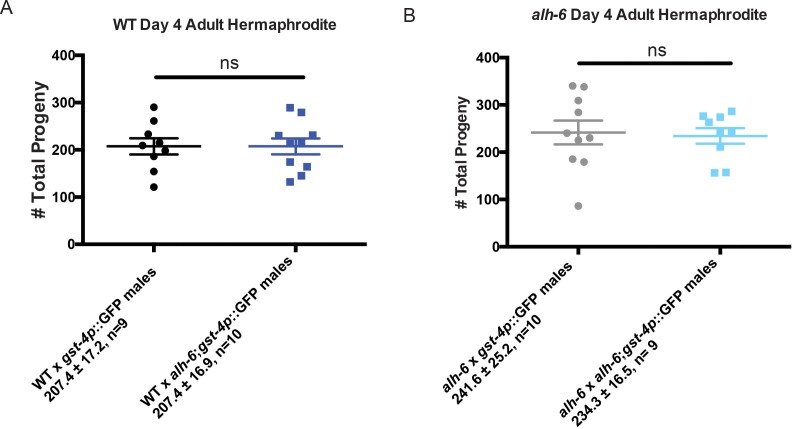
alh-6 fertility defects are sperm-specific.(A) Day four adult WT hermaphrodites mated to either gst-4p::gfp or alh-6;gst-4p::gfp males yield similar total brood size. (B) Day four adult alh-6 hermaphrodites mated to either gst-4p::gfp or alh-6;gst-4p::gfp males yield similar total brood size. Comparisons made with unpaired t-test. *, p<0.05; **, p<0.01; ***, p<0.001; ****, p<0.0001. All studies performed in biological triplicate; refer to Supplementary file 1 for n for each comparison.